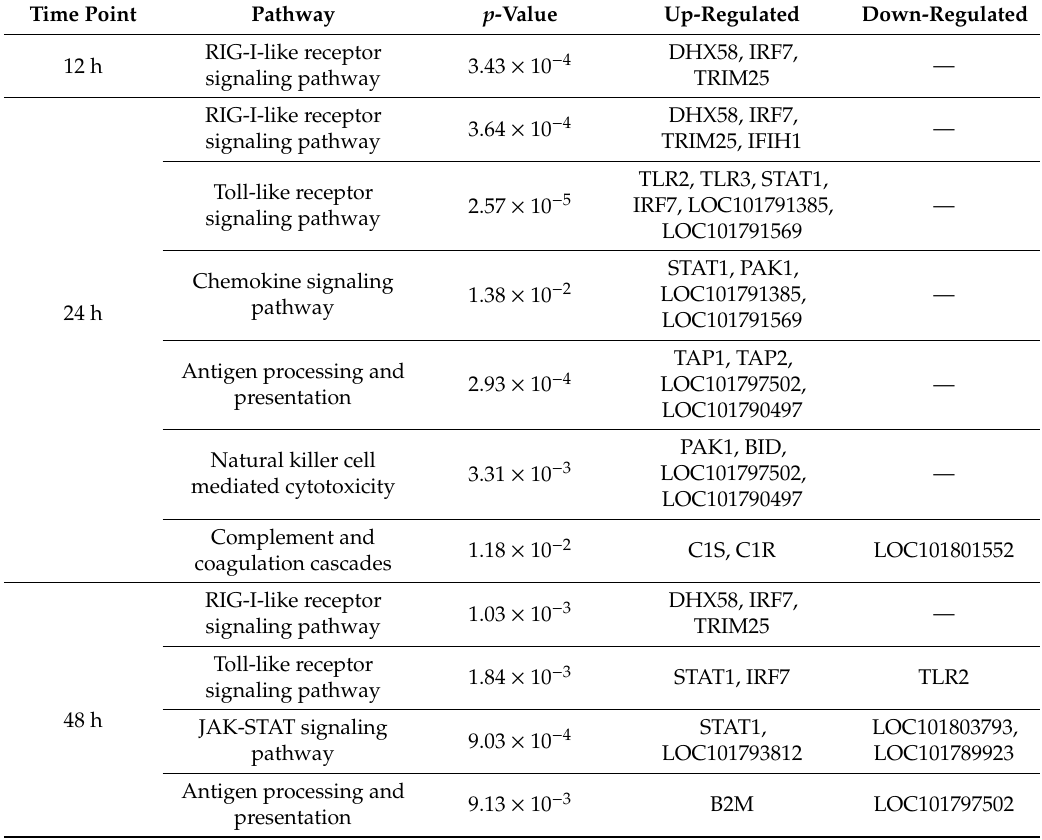
Table 2. KEGG pathways related to immune responses during duck Tembusu virus (DTMUV) infection. Time Point